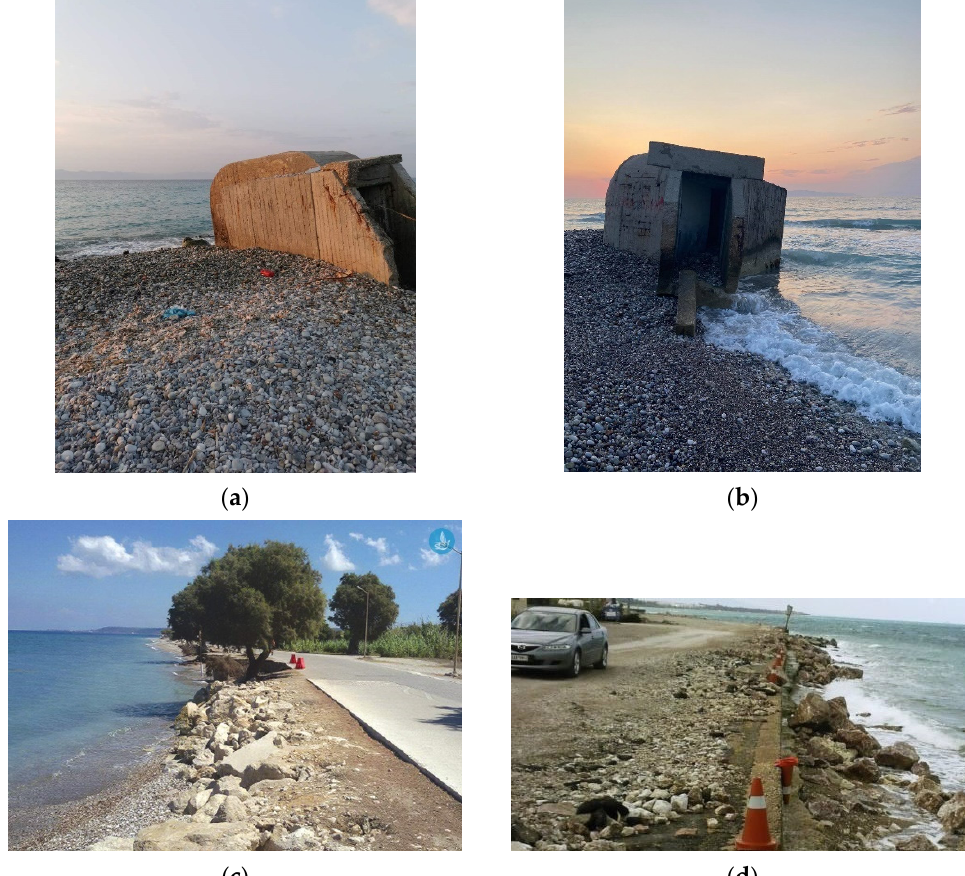
Figure 11. Representative highly to very highly vulnerable sites due to SLR in Rhodes Island: ( a – c ) Ialysos–Paradeision area; ( d ) Faliraki Bay. The flooded constructions in ( a , b ) are old guardhouses.